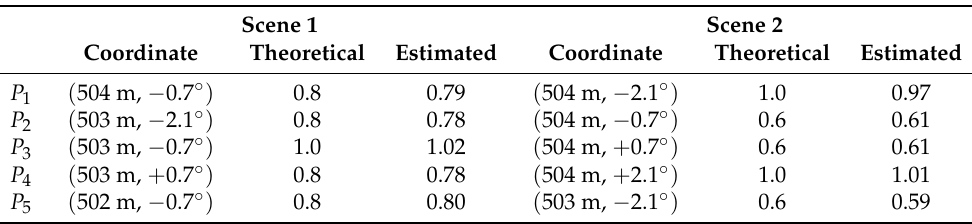
Table 4. Partial RCS estimation results of the scattering points.